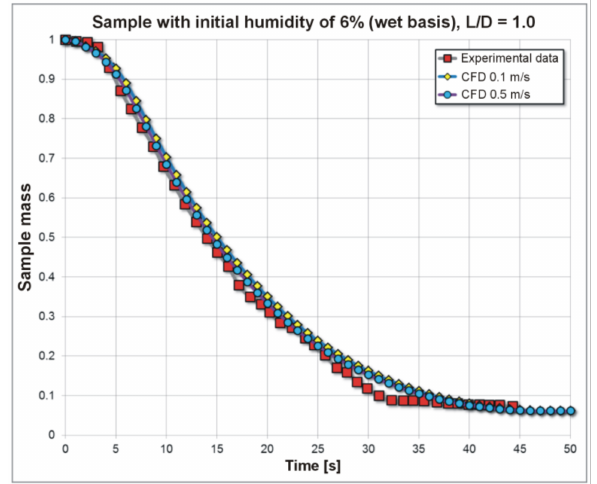
Figure 4. Comparison between simulated and experimental results [2] for pyrolysis of 6% initial moisture sample (determined on wet basis) and L/D = 1—3D